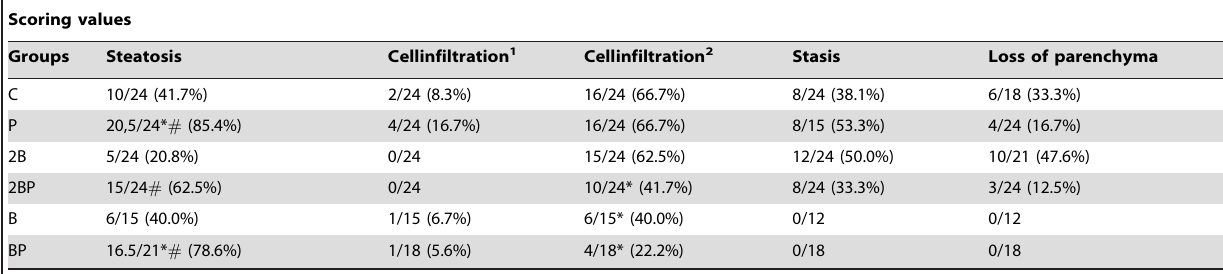
Table 2. Evaluation of liver injury (Scoring